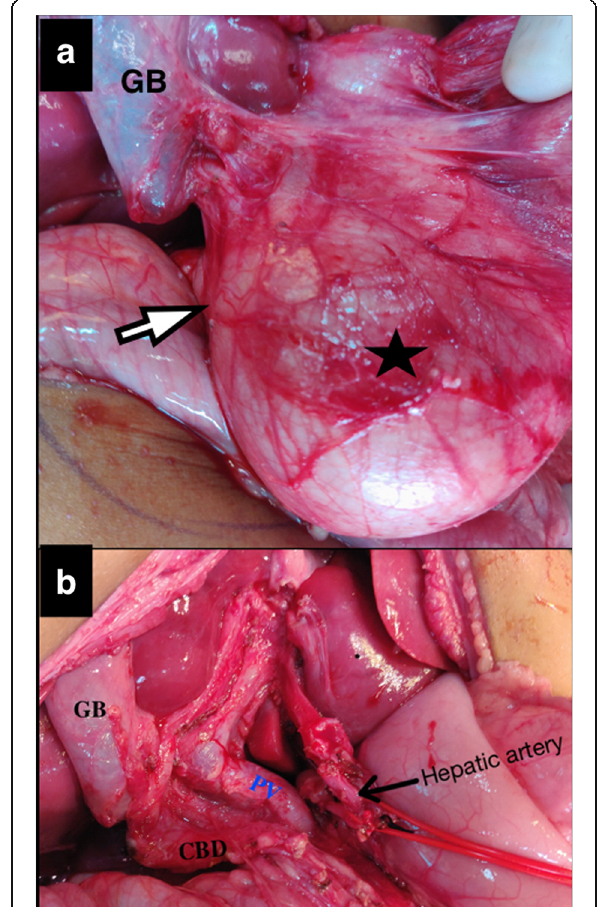
Fig. 2 a Intraoperative image showing the relations of the mass (star) with the CBD (arrow), superiorly extending up to the porta hepatis. b The structures in the tumor bed after the excision is